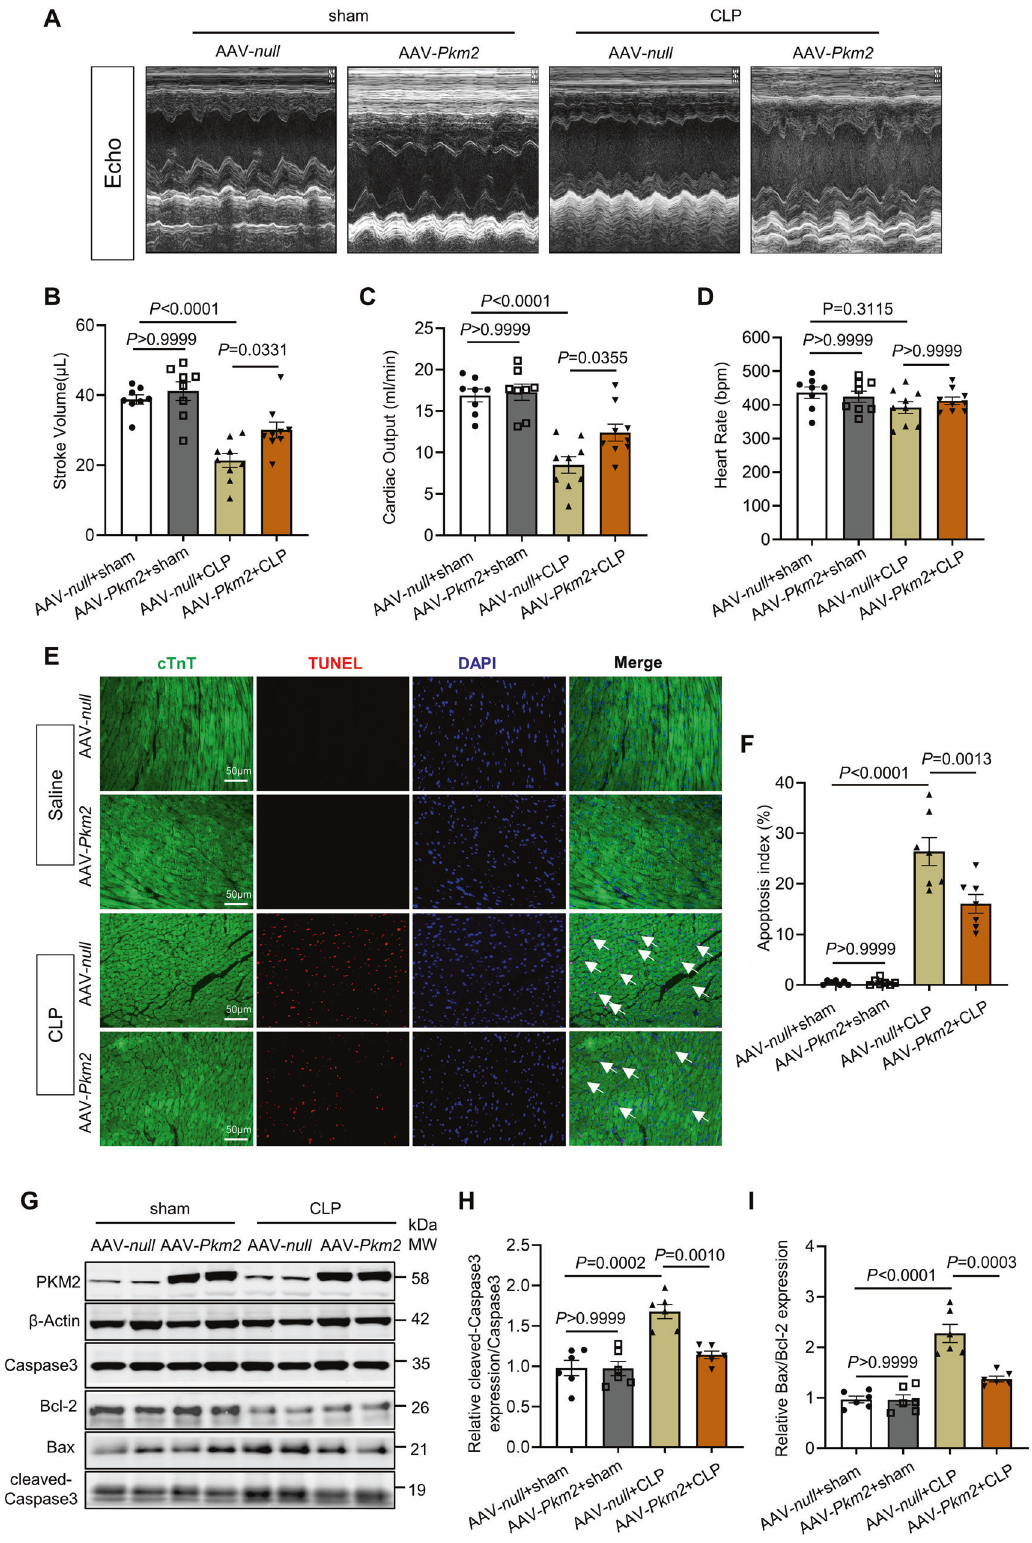
Fig. 7 PKM2 overexpression in cardiomyocytes alleviated cecum ligation and puncture (CLP)-induced cardiomyopathy in vivo. A Representative M-mode echocardiography from littermate injected AAV9- null or AAV9- Pkm2 virus after CLP surgery. B – D Quantitative analysis of stroke volume (SV), cardiac output (CO), and heart rate by echocardiography, n = 8. E , F Representative images and quanti fi cation of TUNEL staining, n = 7. Scale bar: 50 µm. White arrows point to TUNEL positive cardiomyocytes. G – I Western blot and quantitation of apoptosis markers (cleaved-Caspase 3/Caspase3 and Bax/Bcl-2 ratio) expression in hearts of littermate injected AAV9- null or AAV9- Pkm2 virus after CLP surgery. β -Actin served as the loading control, n = 6.